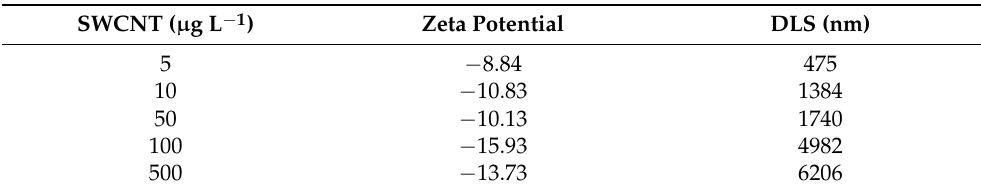
Table 1. Single-walled carbon nanotube (SWCNT) dispersed in SRNOM: concentration dependent agglomerate size